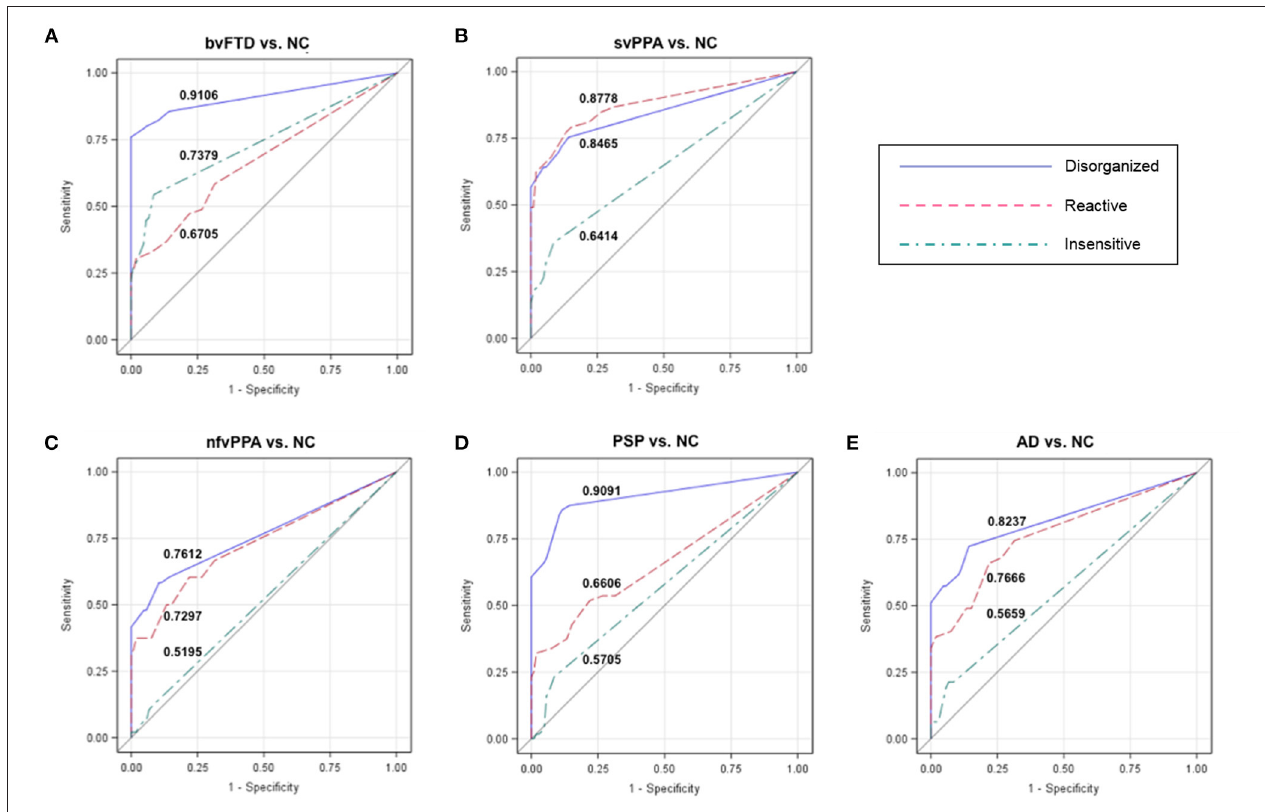
FIGURE 2 | Receiver operating characteristic (ROC) curves for each patient group vs. NCs. The numbers in each graph show the ROC area under the curve (AUC) for each subscale and group comparison (patients vs. controls). The Disorganized subscale can distinguish (A) patients with behavioral variant frontotemporal dementia (bvFTD) from healthy controls (NC) with a probability of 91.06%, and (D) patients with progressive supranuclear palsy (PSP) from NC with a probability of 90.91%. The Reactive and Disorganized subscales have similar probabilities to differentiate patients with (B) semantic variant primary progressive aphasia (svPPA) from NC, as well as patients with (E) Alzheimer’s disease (AD) and (C) non-fluent variant primary progressive aphasia (nfvPPA) from NC. NC, healthy older controls; bvFTD, behavioral variant frontotemporal dementia; svPPA, semantic variant primary progressive aphasia; nfvPPA, non-fluent variant primary progressive aphasia; PSP, progressive supranuclear palsy; AD, Alzheimer’s